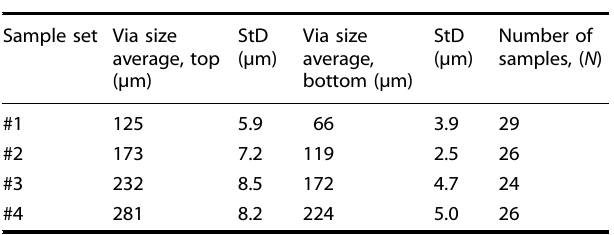
Fig. 1 Multi-layered energy module. An energy module using screen-printed vias as the interconnection between energy storage and harvesting components.